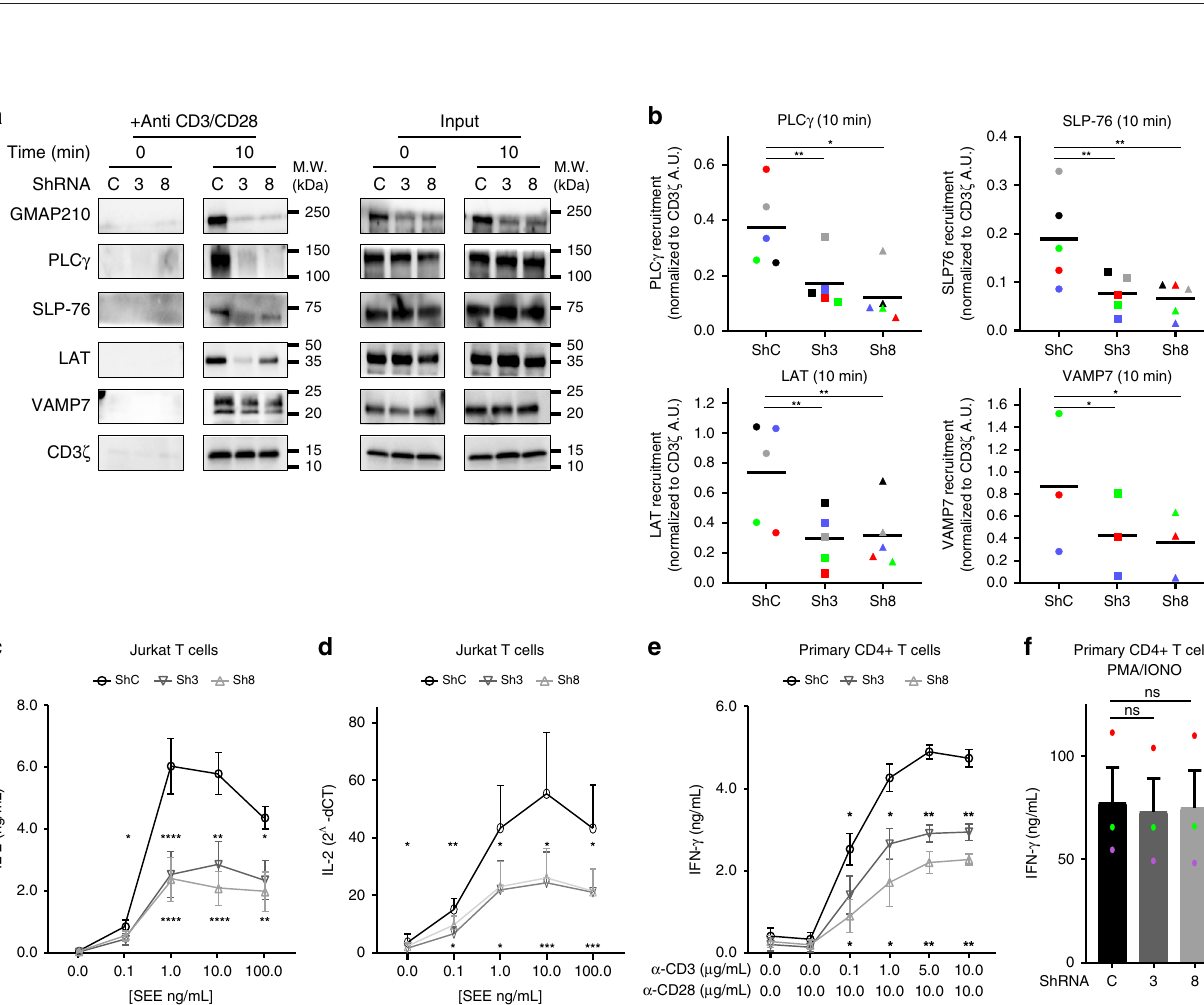
Fig. 3 GMAP210 expression controls formation of the immune synapse. a , b Confocal images a and quanti fi cation b of the enrichment of LAT (left pannel) and CD3 ζ -GFP (rigth pannel) at the immune synapse (depicted by the dotted white line) in Jurkat “ mean cells ” expressing non-targeting control ShRNA c or GMAP210-targeting ShRNA (3 and 8) and interacting for 30 min with Raji cells left unpulsed ( − , unactivated state) or pulsed with SEE ( + , immune synapse formation). N = number of cells constituting the mean image. Horizontal lines represent median. c and d Confocal images of conjugates of Jurkat cells expressing control (C) or GMAP210-speci fi c shRNA (3 and 8) and SEE-pulsed Raji B cells (blue) labeled with anti-phospho LAT (P-LAT, showed in green, left pannel) or anti-phospho-ZAP70 (P-ZAP, showed in green, right pannel) and anti-GMAP210 (red) antibodies, assessed at 30 min c , and quanti fi cation d of the mean fl uorescence intensity of P-LLAT and P-ZAP70, assessed in a fi xed region of the immunimmune synapse and divided by the average of the mean intensities measured in three regions of the same size at the plasma membrane outside of the IS. Horizontal lines represent median. e TIRF images of endogenous LAT, P-LAT, P-ZAP70, or CD3 ζ -GFP in Jurkat cells expressing non-targeting control ShRNA c or GMAP210-speci fi c ShRNA (3, 8), incubated for 10 min on coverslips coated with poly- L -Lysine alone (resting conditions) or anti-CD3 ε + antiCD28 Abs ( α -CD3 α -CD28, activating conditions) before fi xation and staining. f Quanti fi cation, in the evanescent fi eld, of the density of the number of punctas of different proteins and phospho- proteins in Jurkat cells. Each dot = one cell; horizontal lines = median. Scale bars = 5 μ m, ** P < 0.01, **** P < 0.0001, ns: non-signi fi cant (one-way ANOVA). Data are from two independent experiments in a , b , c , and d and three independent experiments in e and f